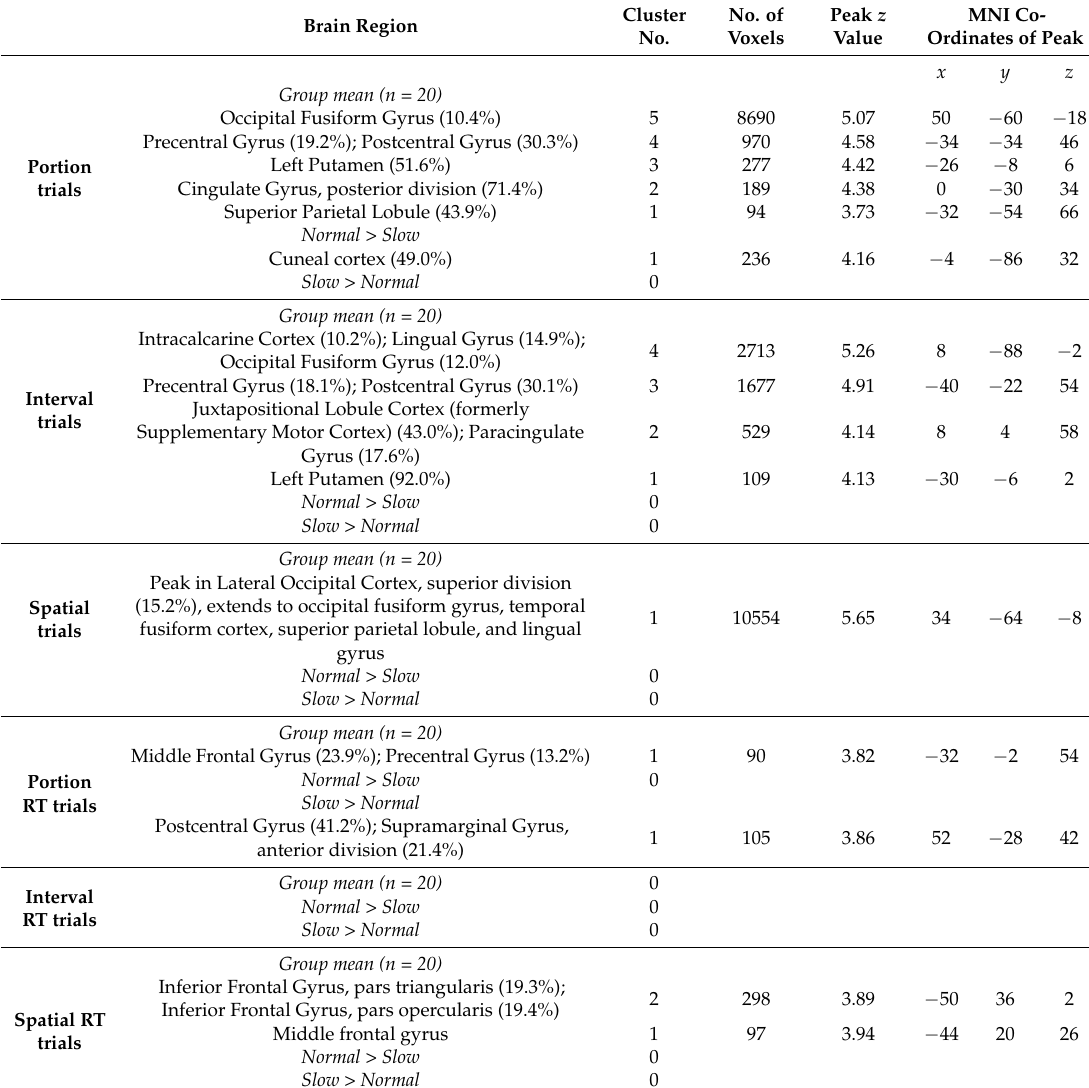
Table A5. Whole-brain analysis Results. Brain Region